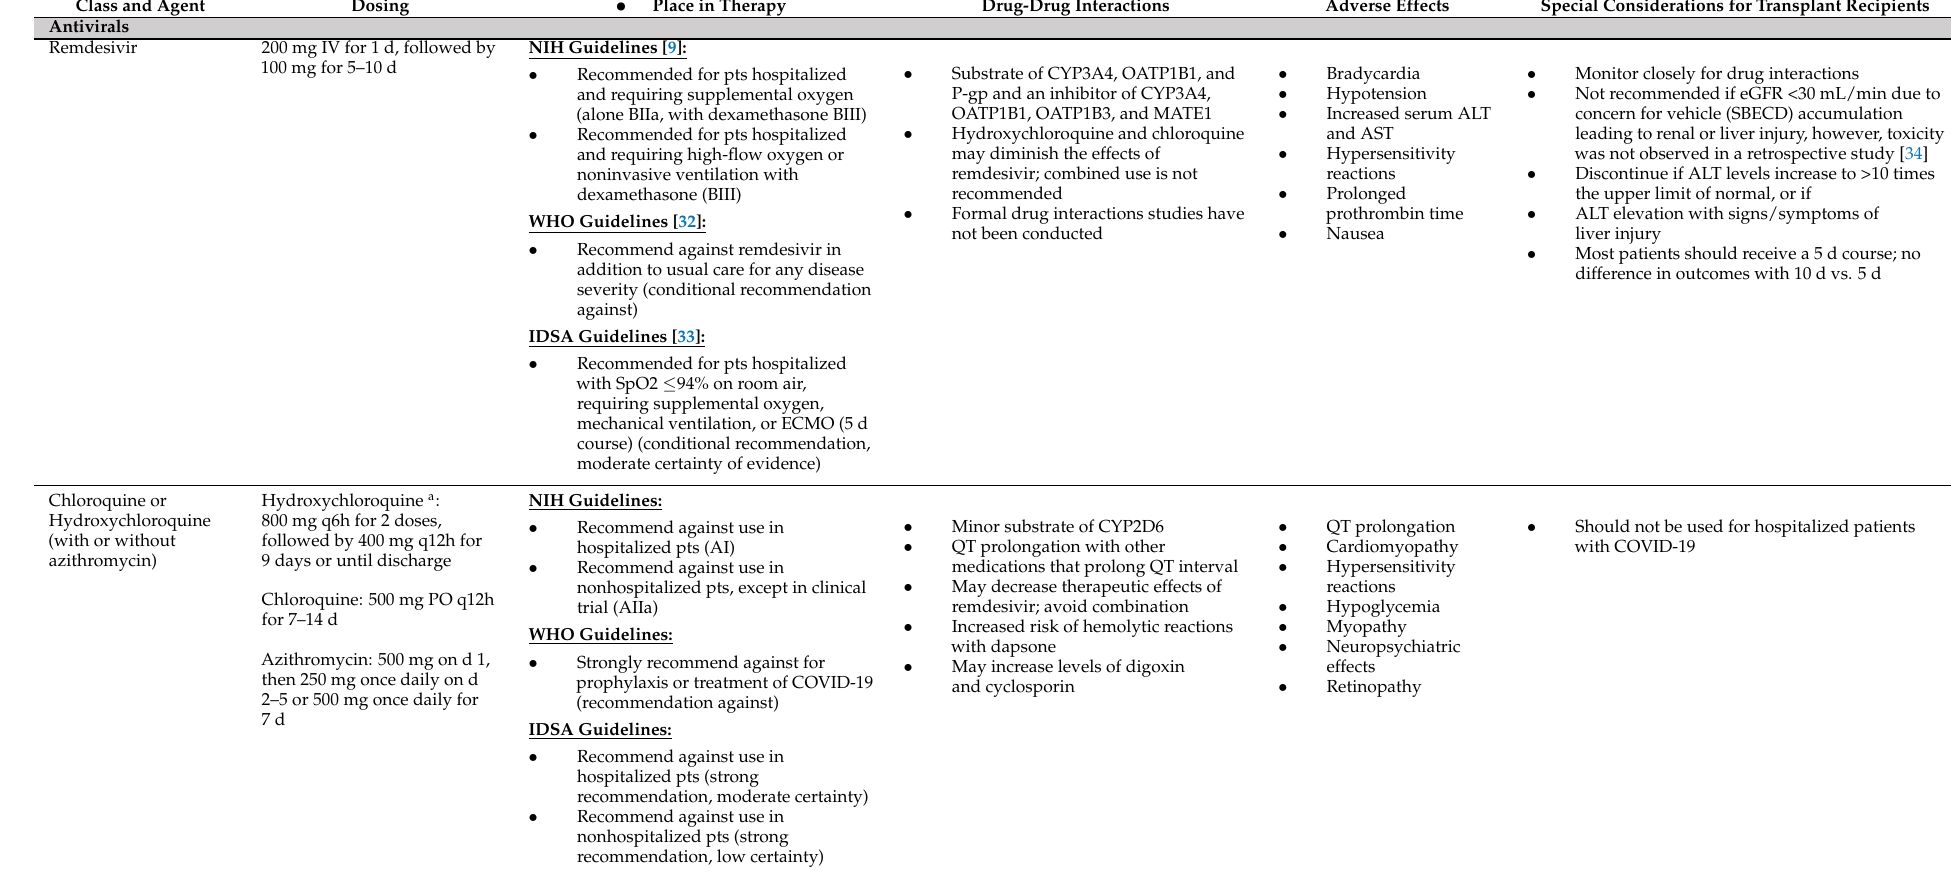
Table 1. Characteristics of Proposed Therapies for the Treatment of